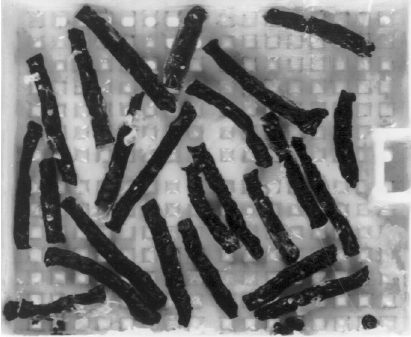
Fig. 1. Embedding cassette with celloidin cylinders after staining, dehydration and paraffin